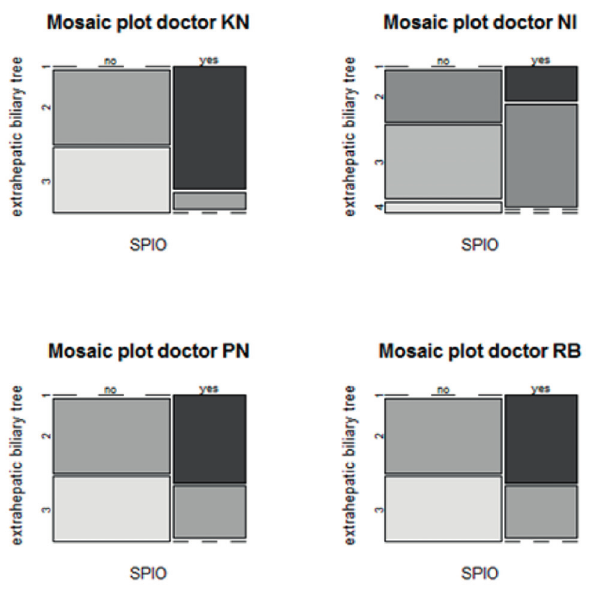
Fig. 1. Mosaic plots-statistic evaluation of extrahepatic biliary duct in patients with ascites in 4 radiologists separately (KN, NI, PN, RB). Mosaic plots as a statistic evaluation of the an- swers of four radiologists on the given question from the blind questionnaire: “How is the visualization of extrahepatic biliary tree in patients suffering of ascites?” [1. excellent (80-100%), 2. sufficient (50-80%), 3. insufficient (less than 50%), 4. impos- sible to